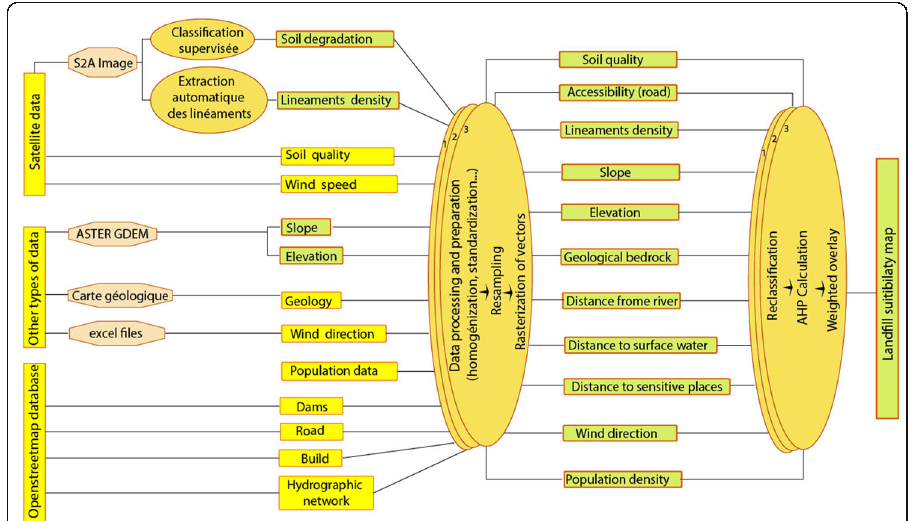
Fig. 2 Flow chart of the methodology adopted in the